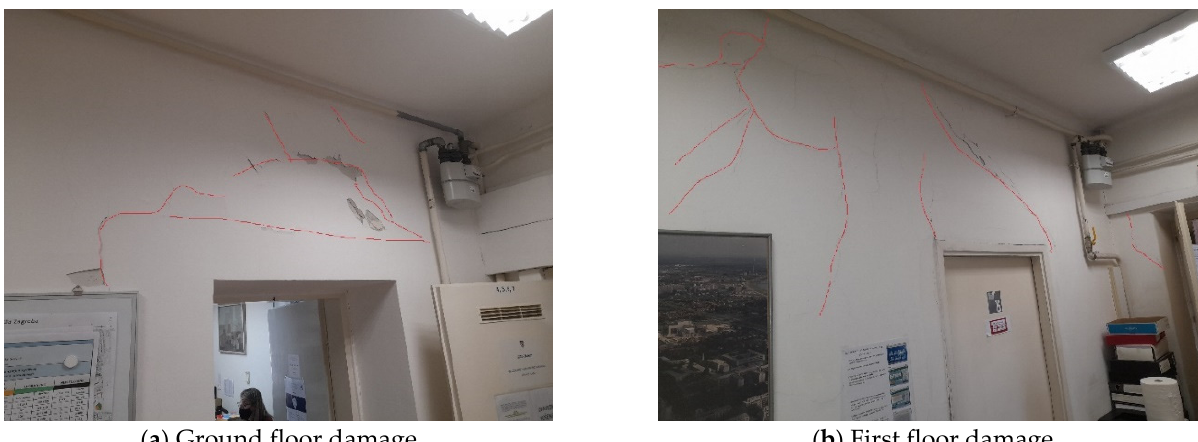
Figure 20. Damage to the central wall in the x -direction.